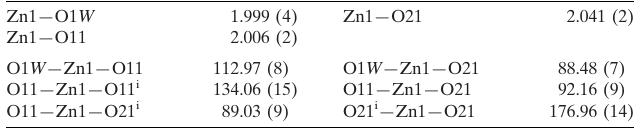
Selected geometric parameters (A˚ , (cid:4) ).